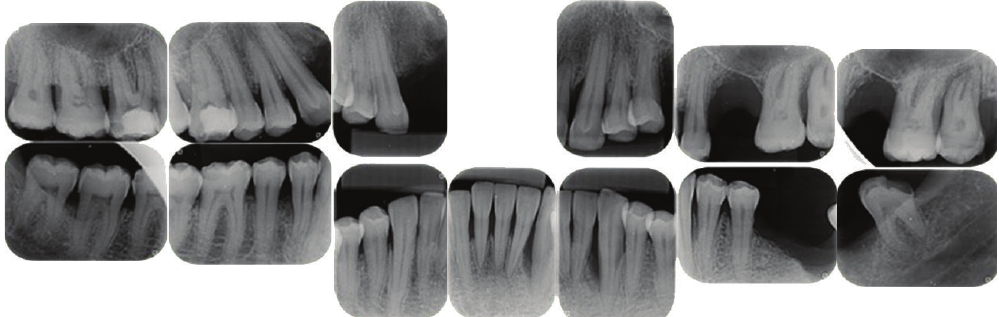
Figure 2: Radiographic features of severe periodontal disease. Generalized vertical and horizontal bone loss.